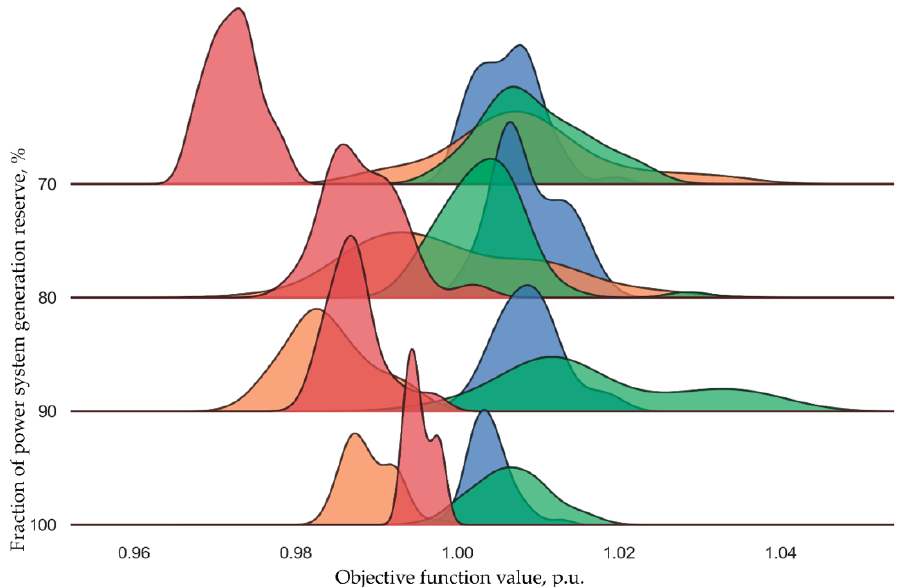
Figure 7. The probability distributions of the resultant objective function values for a number of fractions of the power system generation reserve (70%, 80%, 90%, and 100% of the initial reserve) and the degree of diversity of the list of generators to be repaired (128 generators to be repaired (red), 64 generators to be repaired (blue), 32 generators to be repaired (orange), and 16 generators to be repaired (green)).